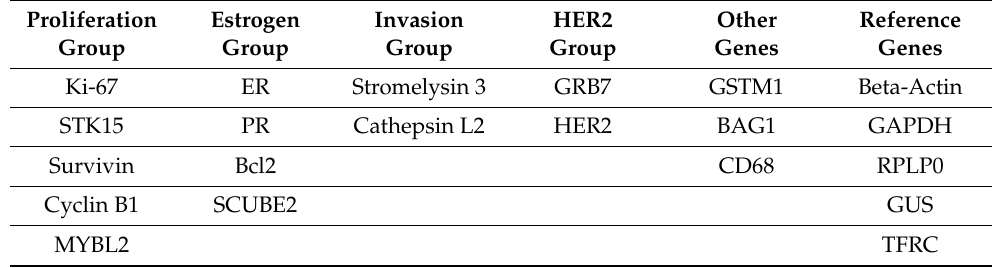
Table 1. Oncotype DX 21 gene classification into various